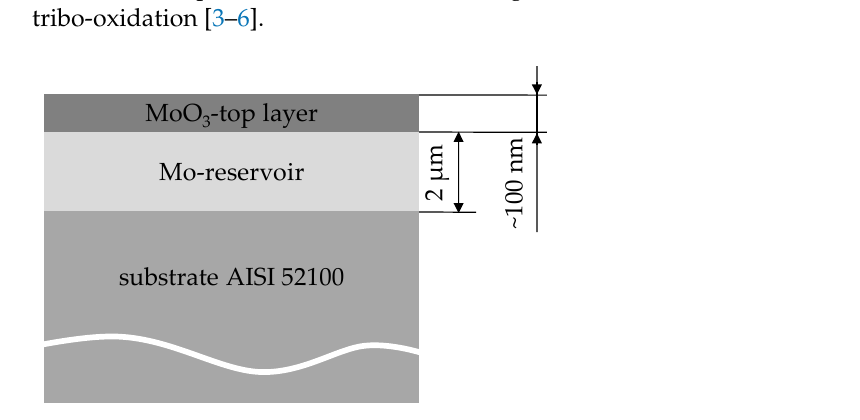
Figure 1. Schematic structure of the self ‐ regenerative molybdenum layer system.